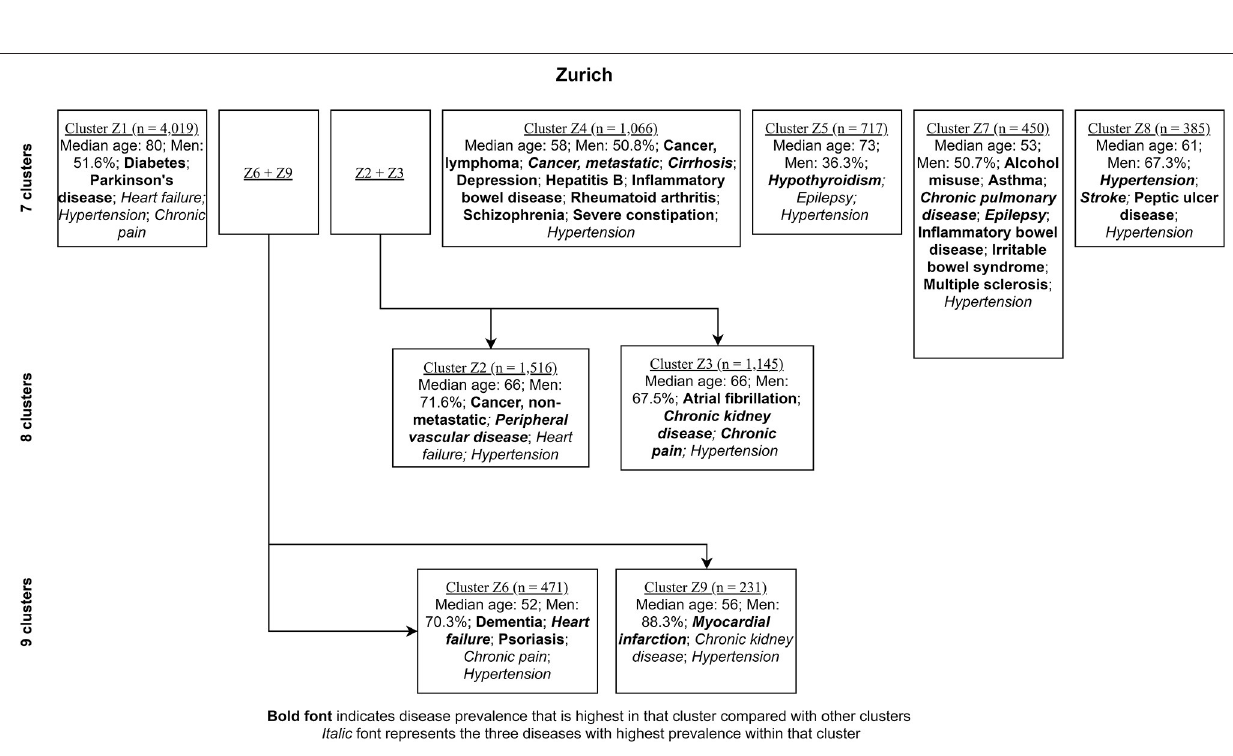
Frontiers in Medicine |